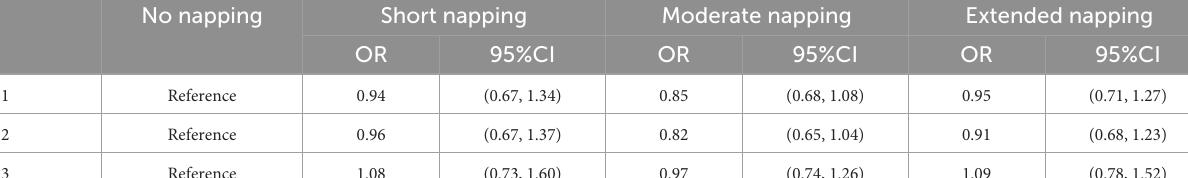
TABLE 2 Association of daytime nap duration and frailty at baseline from the China Health and Retirement Longitudinal Study ( n = 5,126). No napping Short